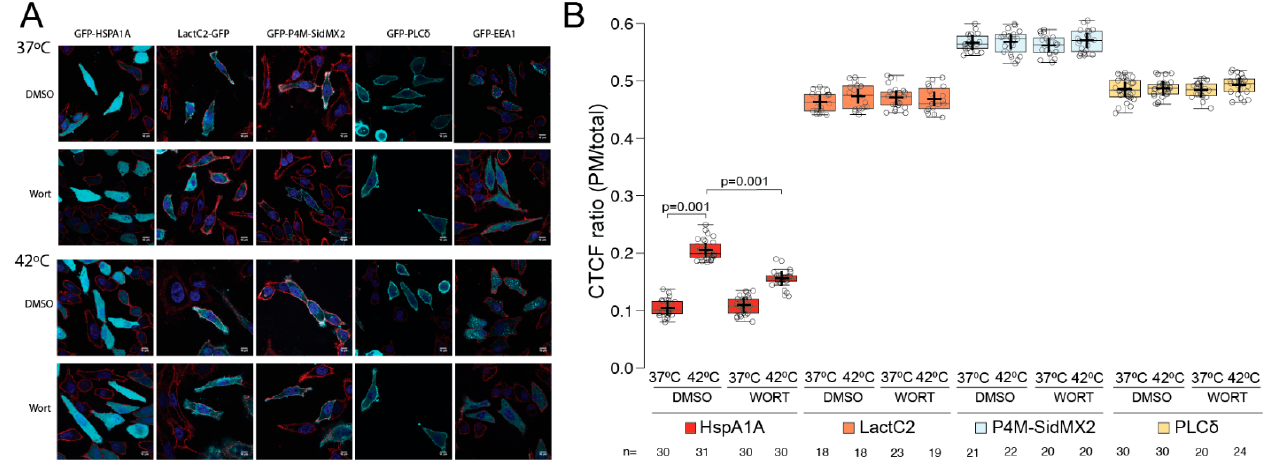
Figure 7. HSPA1A localization at the plasma membrane is significantly reduced by treatment with wortmannin. ( A ) Representative images of HeLa cells expressing GFP-HSPA1A (first column from the left), Lact-C2-GFP (second column), GFP-P4M-SidMx2 (third column), GFP-PLC δ -PH (fourth column), and GFP-EEA1 (fifth column). In all cases, the PM was stained with WGA-FA555 and the nucleus with DAPI. The PM localization of the proteins was documented at either control conditions (37 °C; top panels) or heat-shocked conditions (1 h at 42 °C/8 h at 37 °C; bottom panels). Negative control cells were treated with DMSO. Scale bar = 10 μ M. ( B ) Quantification of the corrected total cell fluorescence (CTCF) as a ratio between the total GFP fluorescence of HSPA1A, Lact-C2, P4M-SidMx2, or PLC δ -PH at the PM and the rest of the cell at control conditions and after heat shock in the presence of either DMSO (untreated) or wortmannin. Please note that the EEA1 cells were not quantified because they do not localize at the PM. The experiment was repeated three times, and the total number of cells (shown as open circles) per condition are shown at the bottom of the graph. The center lines show the medians; box limits indicate the 25th and 75th percentiles as determined by R software; whiskers extend 1.5 times the interquartile range from the 25th and 75th percentiles; crosses represent sample means.